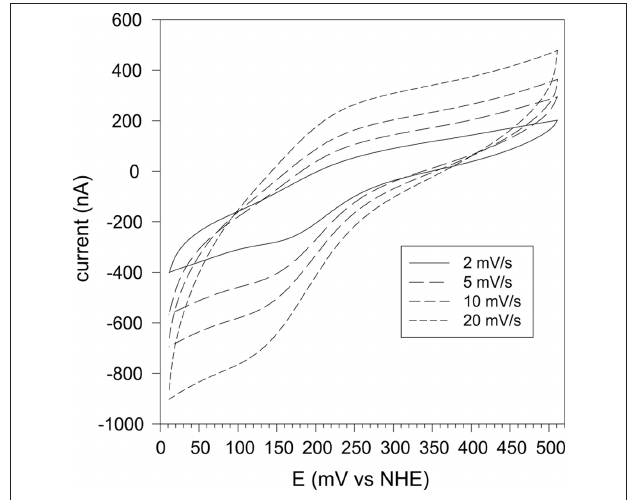
Figure 4 | Cyclic voltammetry of rSmc04048 at sweep rates of 2, 5, 10, and 20 mV/s and at pH 6.9. The protein was soaked into a polymer film cast on a glassy carbon electrode (see Materials and